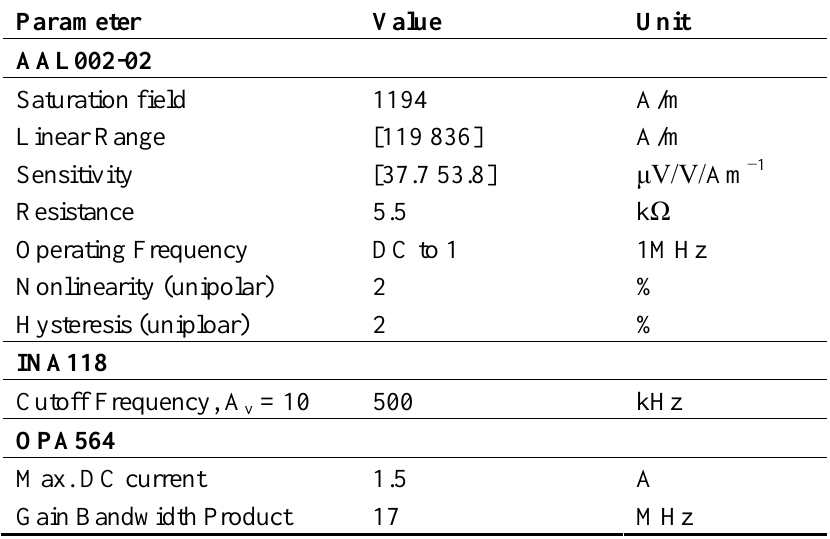
Table 1. Main parameters of the sensor and the